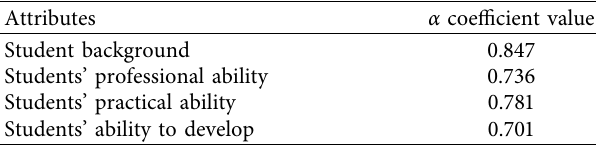
Table 2: Reliability analysis of the